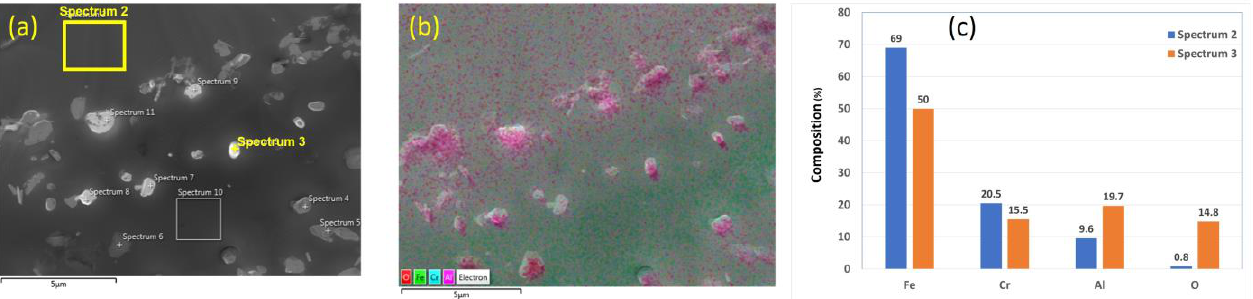
Figure 5. A 17 μ m FeCrAl fiber without heat treatment: ( a ) SEM micrograph image, ( b ) EDS layered image, and ( c ) EDS scans of Spectrum 2 and Spectrum 3.